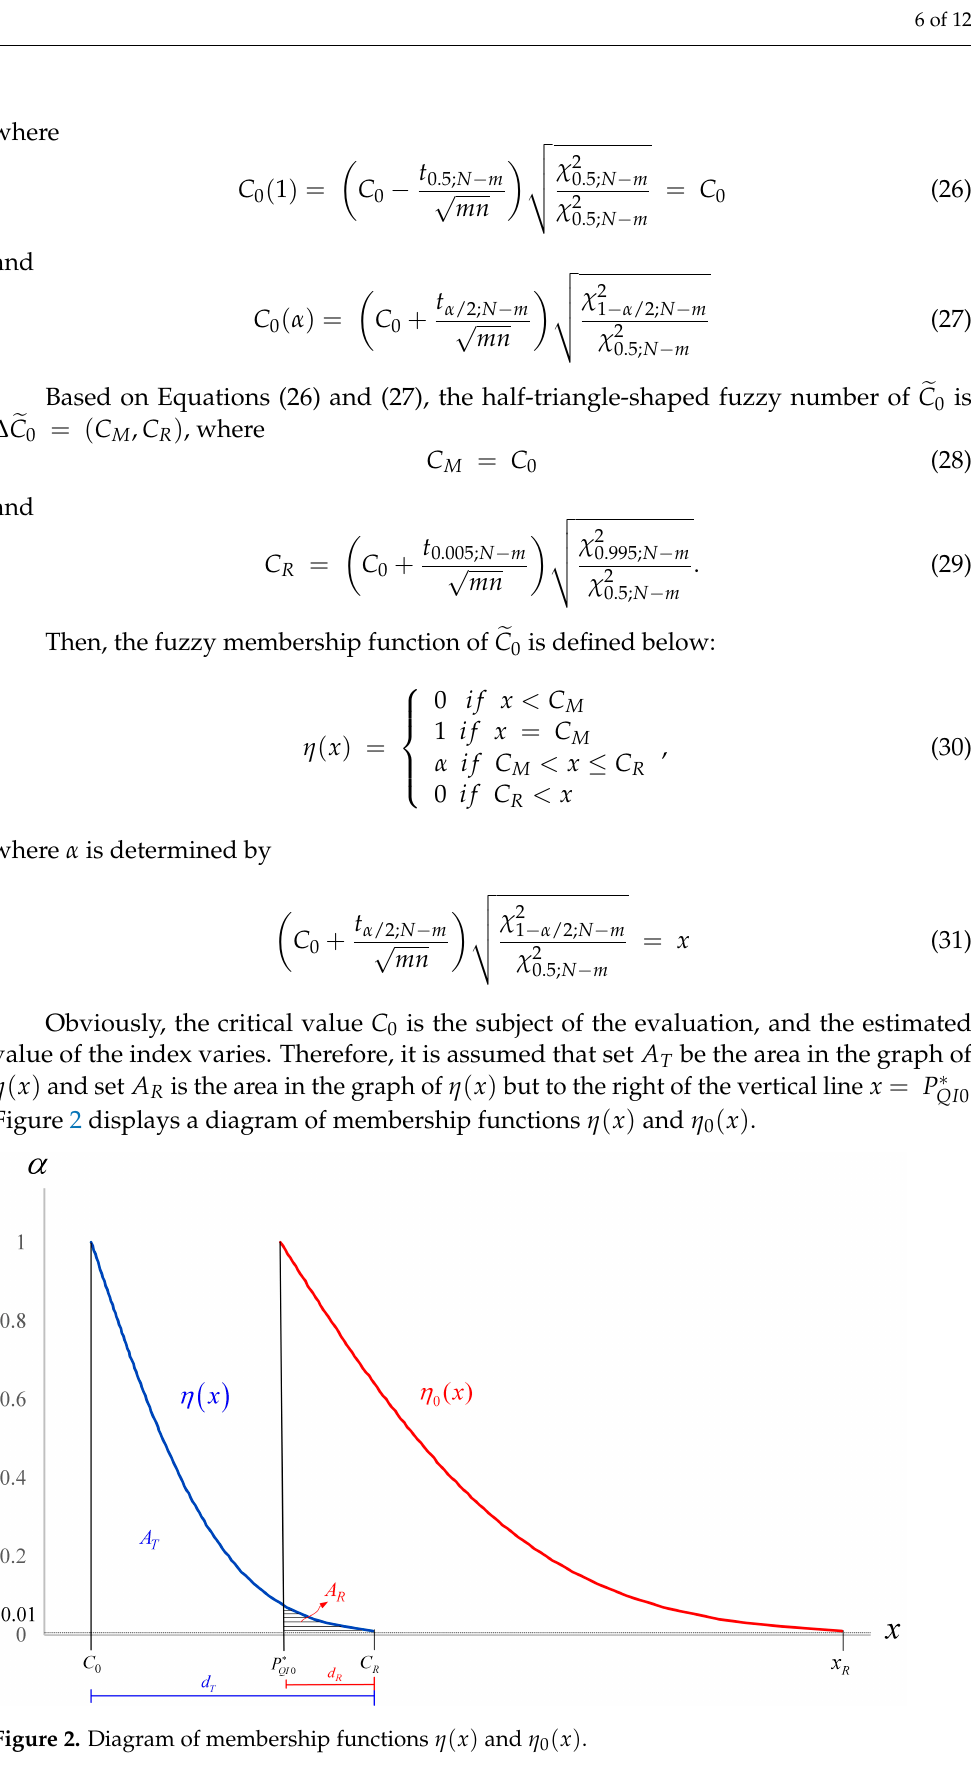
Figure 2. Diagram of membership functions   x  and